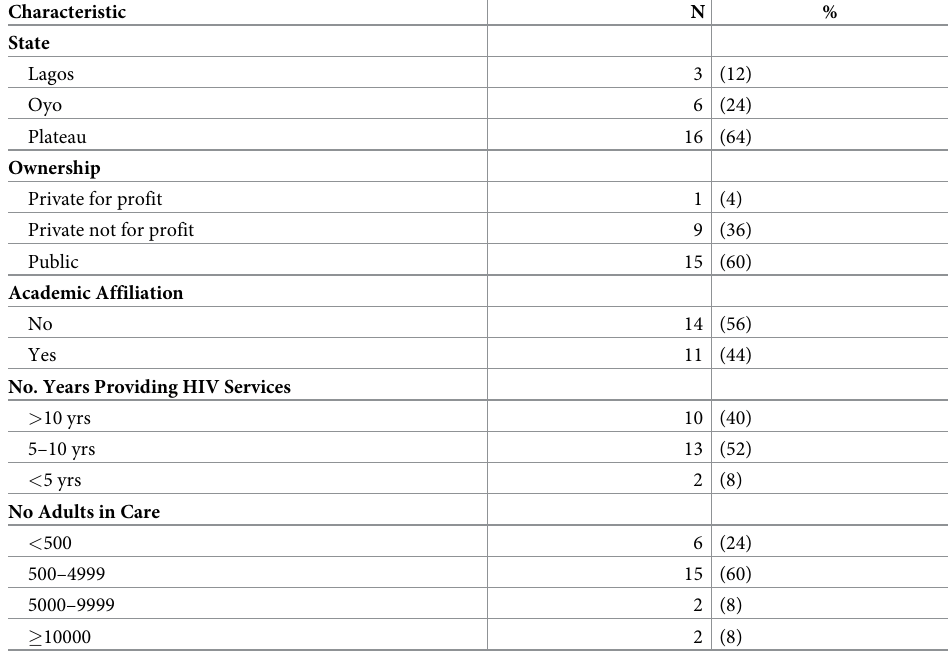
Table 1. Summary of site characteristics of APIN-supported HIV treatment facilities in Nigeria. Characteristic